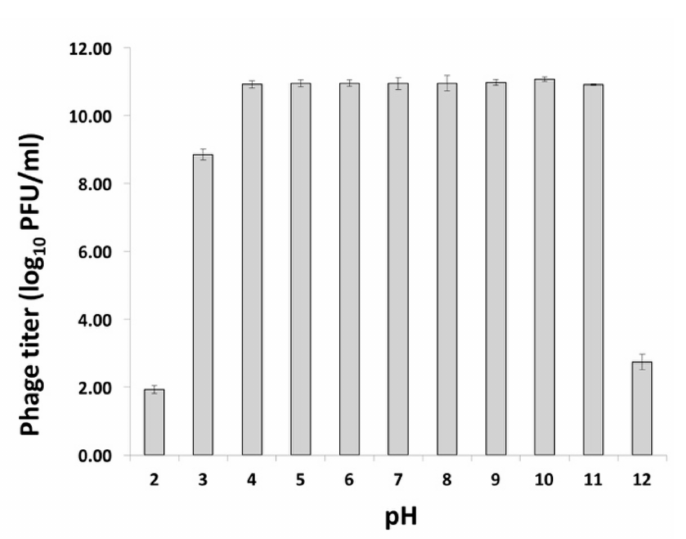
Figure 1. The effect of pH on VR26. Bars present standard